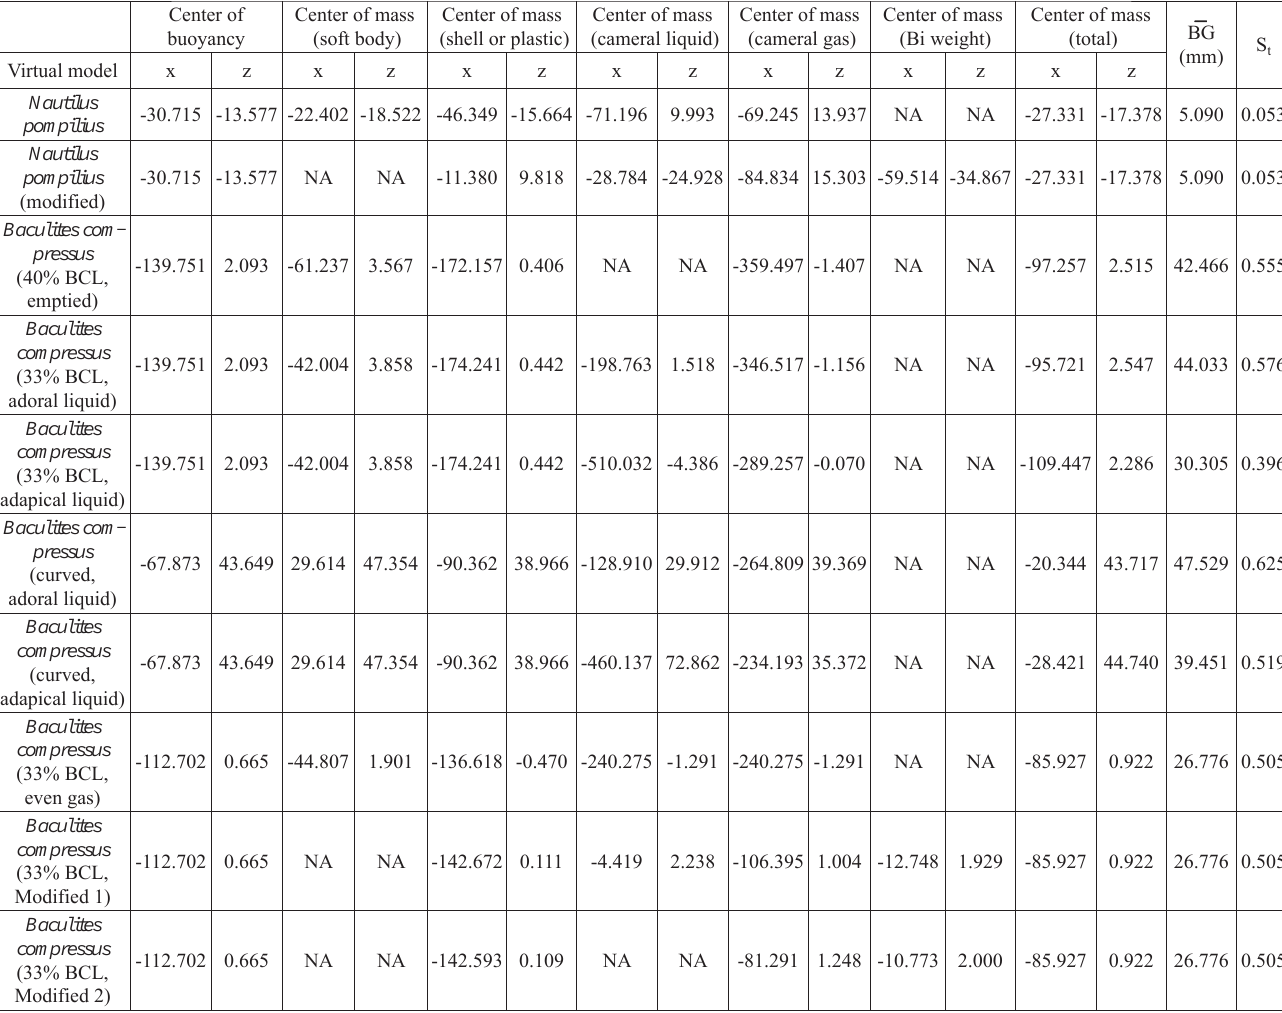
Table 4. The center of buoyancy and centers of mass for each model component (x, z, in mm) in the virtual models. These values, along with the metrics in Table 3 were used to compute hydrostatic stability (S t ). The y component is ignored because all models are bilaterally symmetric. BCL, body chamber ratio; B ͞͞͞͞ G, distance between centers of buoyancy and gravity; Bi, bismuth; NA, not available.